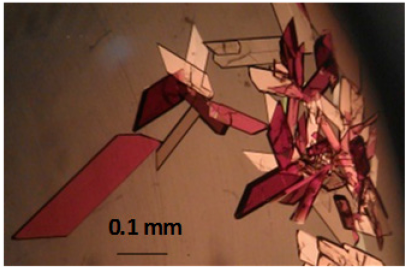
Figure 1. Picture of the crystals of NH 4 Mo 6 (AlePy 2 Mo) 2 in the synthetic medium. NaMo 6 (Ale-4Py) 2 and NaKMo 6 (Ale-4Py) 2 are insoluble in all common solvents. Therefore, it was